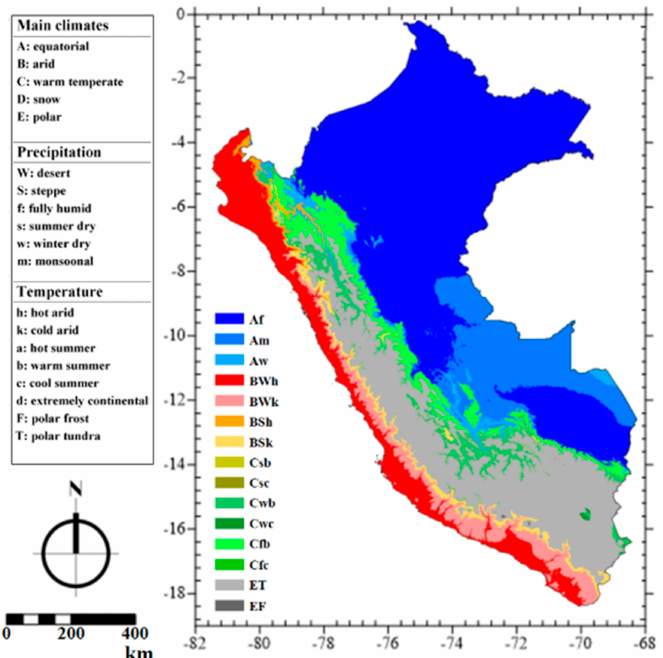
Figure 1. The climate types in Peru according to the Köppen–Geiger climate classification (based on Kottek et al. [49], Beck et al. [50], and Mohammadi et al. [51]).